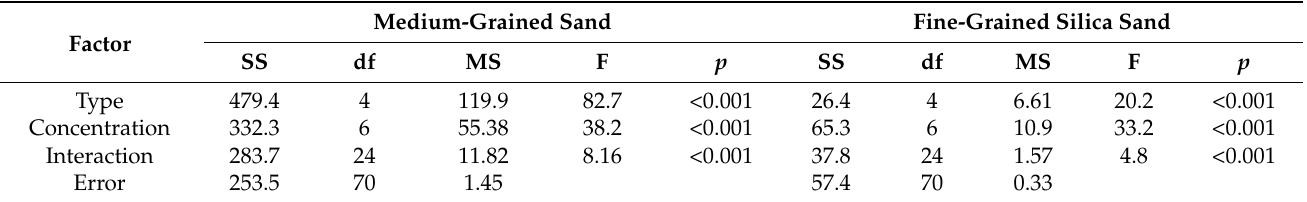
Table 5. Results of two-way ANOVA ( α = 0.05) of penetration resistance test data of Phase 1, investigating the effect of the concentration on the crust penetration